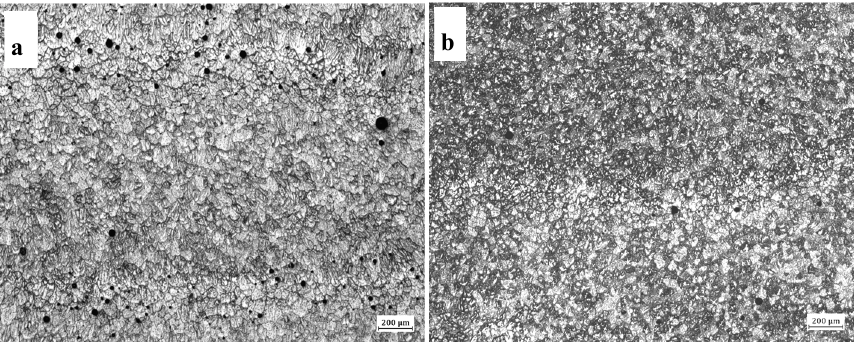
Figure 3. Porosity of single-wire and double-wire walls: ( a ) single-wire wall; ( b ) double-wire